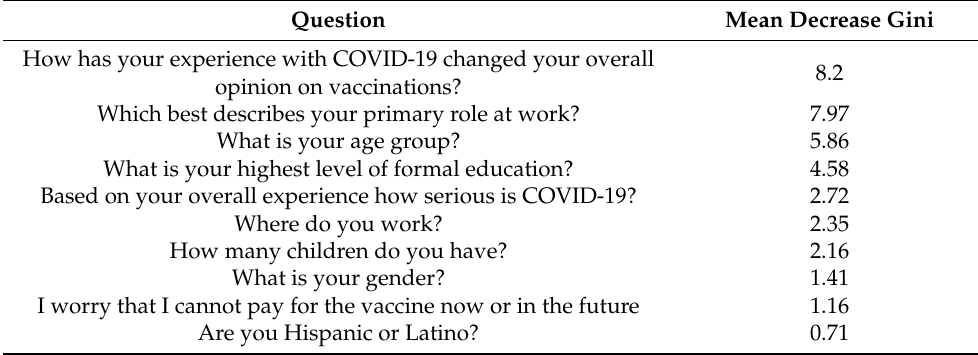
Table 5. Machine learning analysis of survey questions associated with vaccine